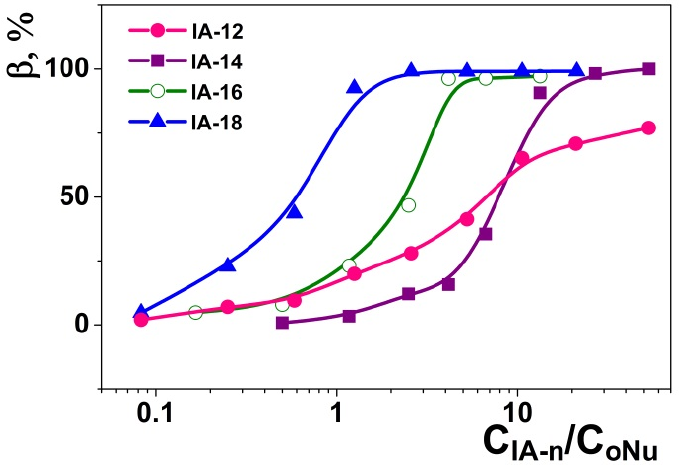
Figure 9. Binding degree of IA-12 with oNu versus IA-n concentration plot for the IA-12/oNu,